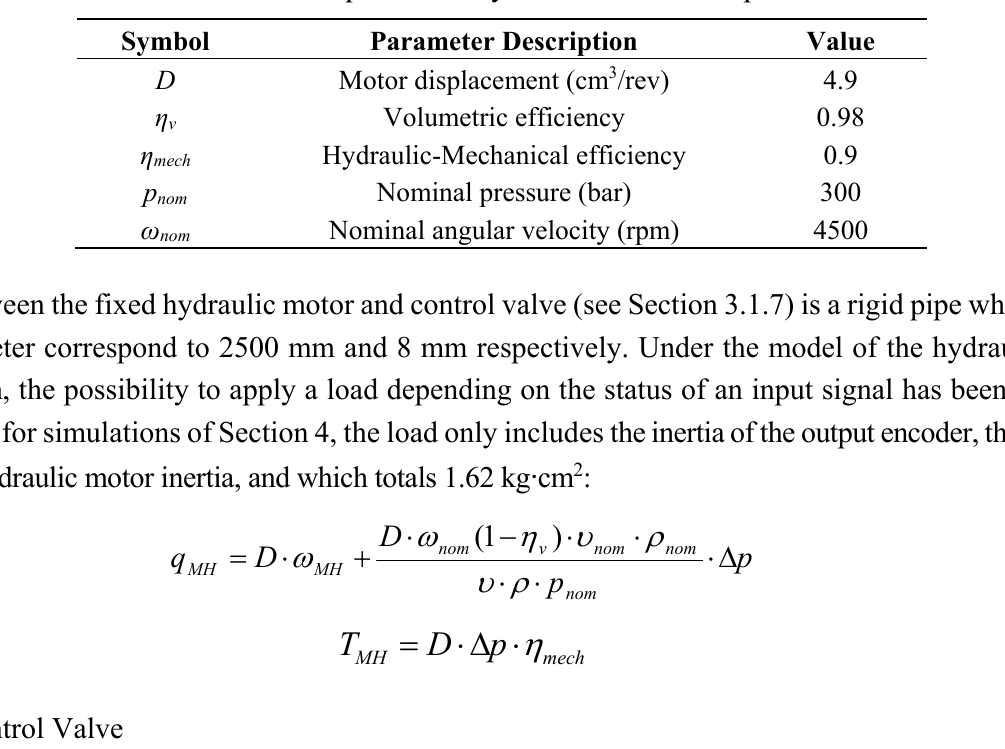
Table 7. Fixed-displacement hydraulic motor main